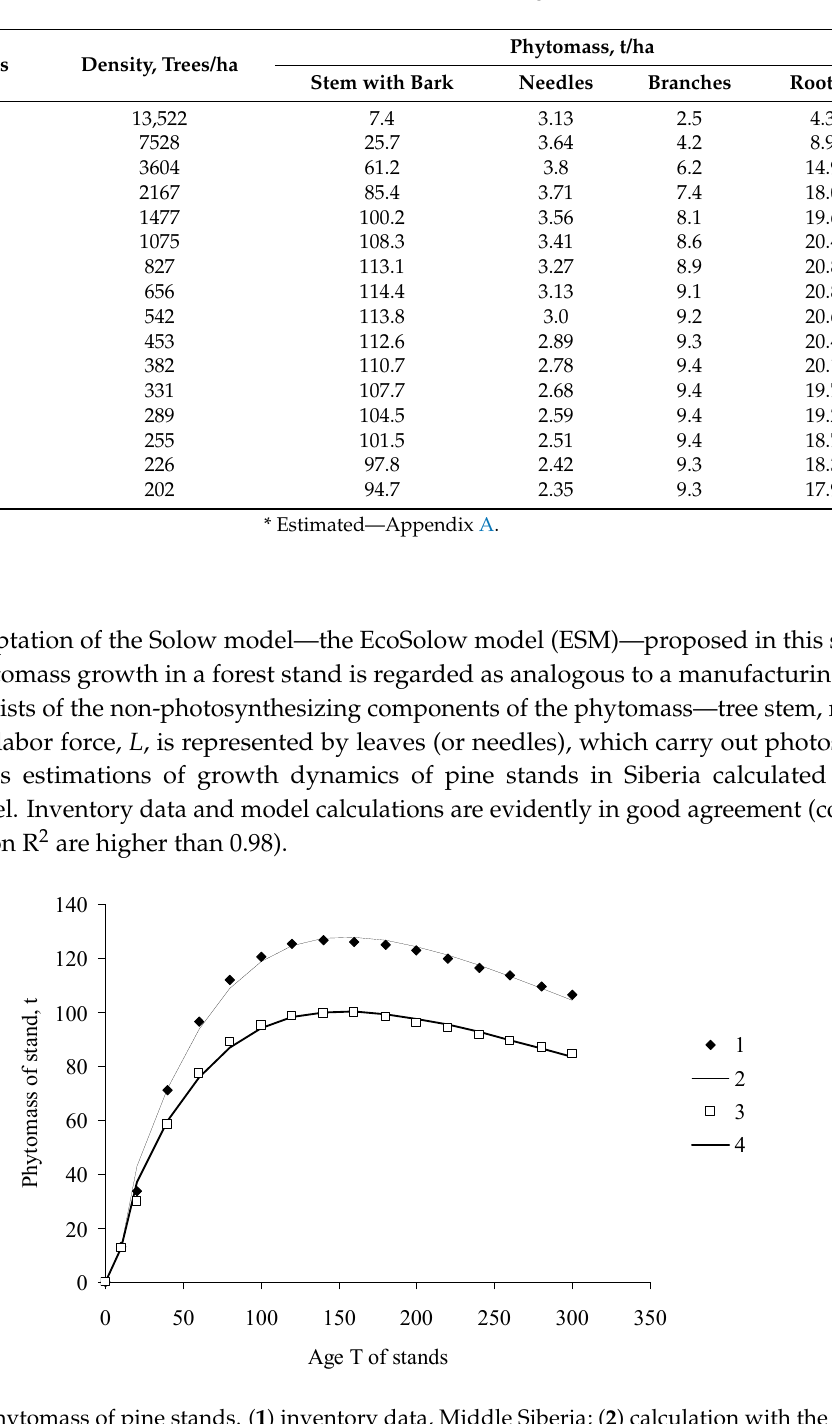
Table 1. Middle Siberia, south taiga.